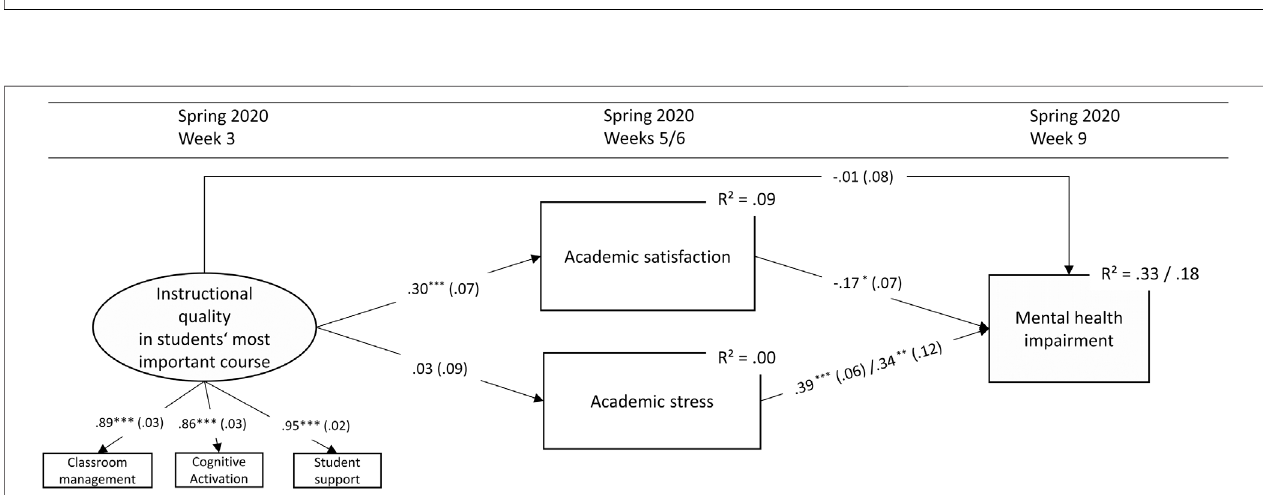
FIGURE 3 | Associations between Instructional Quality in Students ’ most Important Course, Academic Stress, Satisfaction and Mental Health Impairment across Gender (Model A.2). Reported are standardized effects. Gender speci fi c effects for female ( n (cid:1) 137) and male students ( n (cid:1) 62) are reported if the Wald χ 2 -test indicated meaningfuldifferencesineffects.Theorderofreportedgendereffectsis:female/males.Nogenderdifferencesexistifonlyonestandardizedeffectisreported. † p <